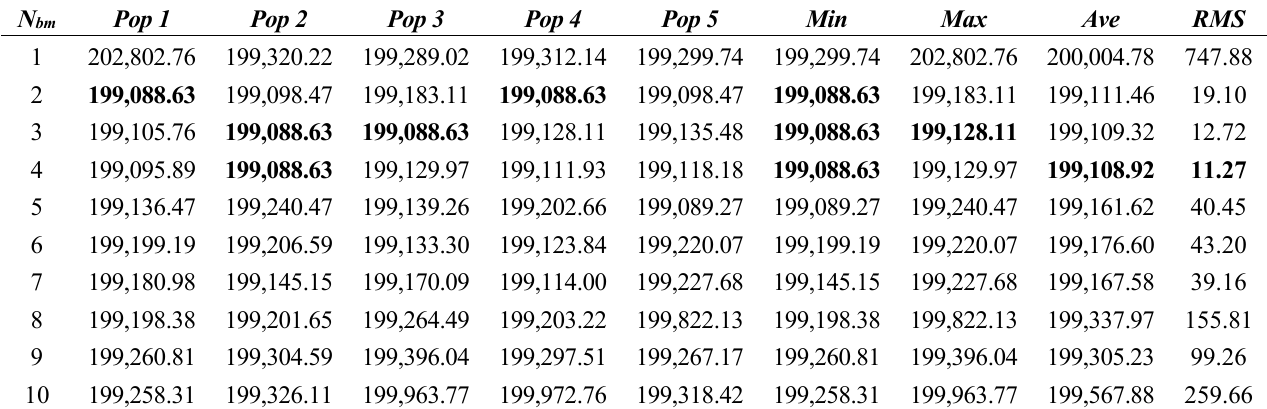
Table 2. World Bank (1991) [61] case study. Optimal results for the case WB-2. N